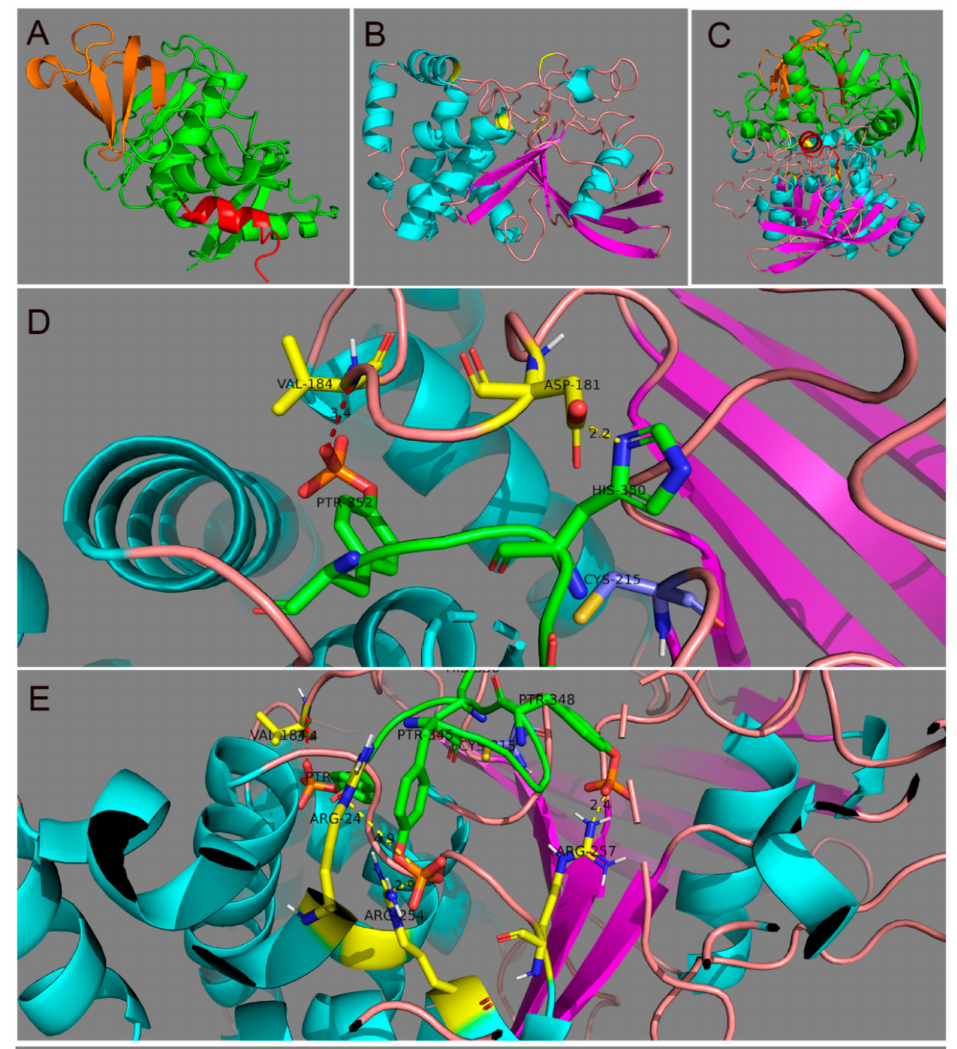
Figure 4. In silico modeling of Grb14 and PTP1B interactions. Cartoon model of Grb14. The binding peptide used for docking simulations is depicted in red. The PH domain is shown in orange ( A ). Cartoon model of PTP1B. The alpha helices are depicted in cyan. β -sheets are shown as purple. The predicted binding site for Grb14 is shown in yellow ( B ). A complex of Grb14 with PTP1B ( C ). The predicted binding interaction of the pGrb14 with PTP1B (pTyr352-Val-184; His350-Asp181) ( D ). The predicted binding interaction of the pGrb14 with PTP1B (pTyr345-Arg24; pTyr345-Arg254; pTyr348-Arg257) ( E ). Green, pGrb14 peptide; Yellow, putative interacting residues of PTP1B. Video files were provided in the Supplementary